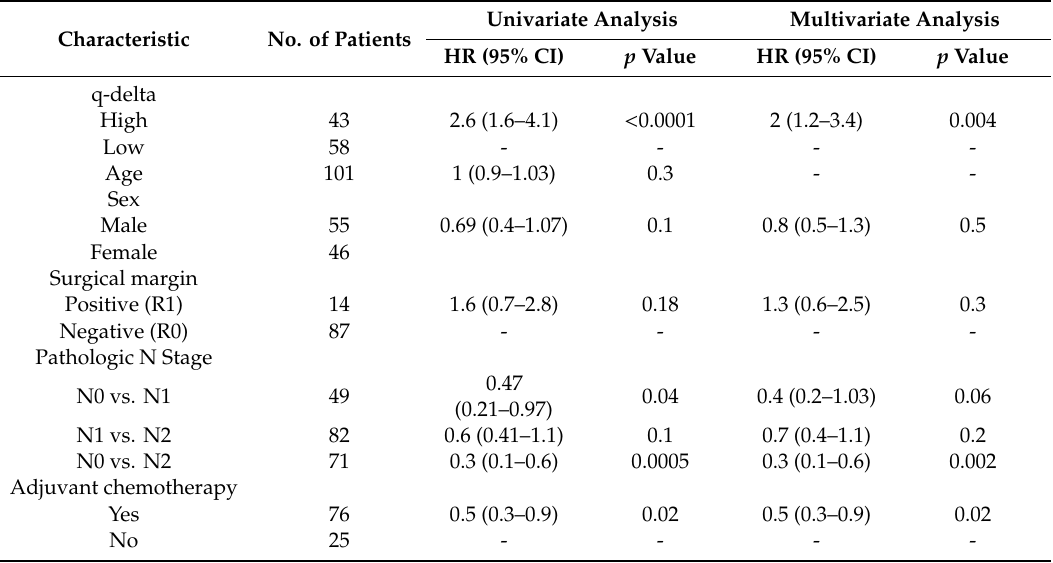
Table 3. Univariate and multivariate analyses of patients who underwent upfront surgery for resectable PDAC (D1).